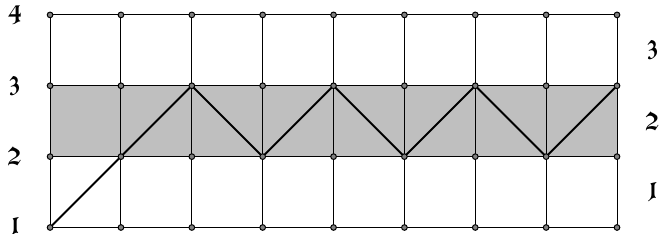
Figure 1 . A minimal path in the vacuum module of the restricted solid-on-solid model L p;p 0 = L 2 ; 5 , labeled by a = 1, b = 2, and c = 3. The numbers on the left label the possible initial points of paths, and correspond to the label s in (cid:31) p;p 0 = (cid:31) 2 ; 5 . The numbers on the right label the possible r;s r;s locations of the ground-state (shaded) bands that paths can end up oscillating in. The number of ground-state bands is the range of the label r in (cid:31) p;p 0 = (cid:31) 2 ; 5 . In this example, there is only one r;s r;s ground state band, and (cid:31) p;p 0 = (cid:31) 2 ; 5 . r;s 1 ; 1